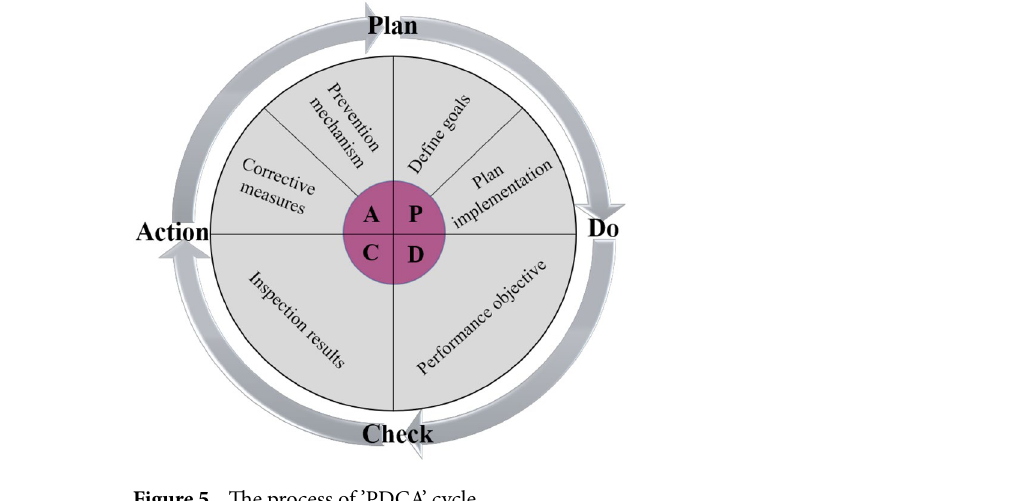
Figure 5. The process of ’PDCA’ cycle.